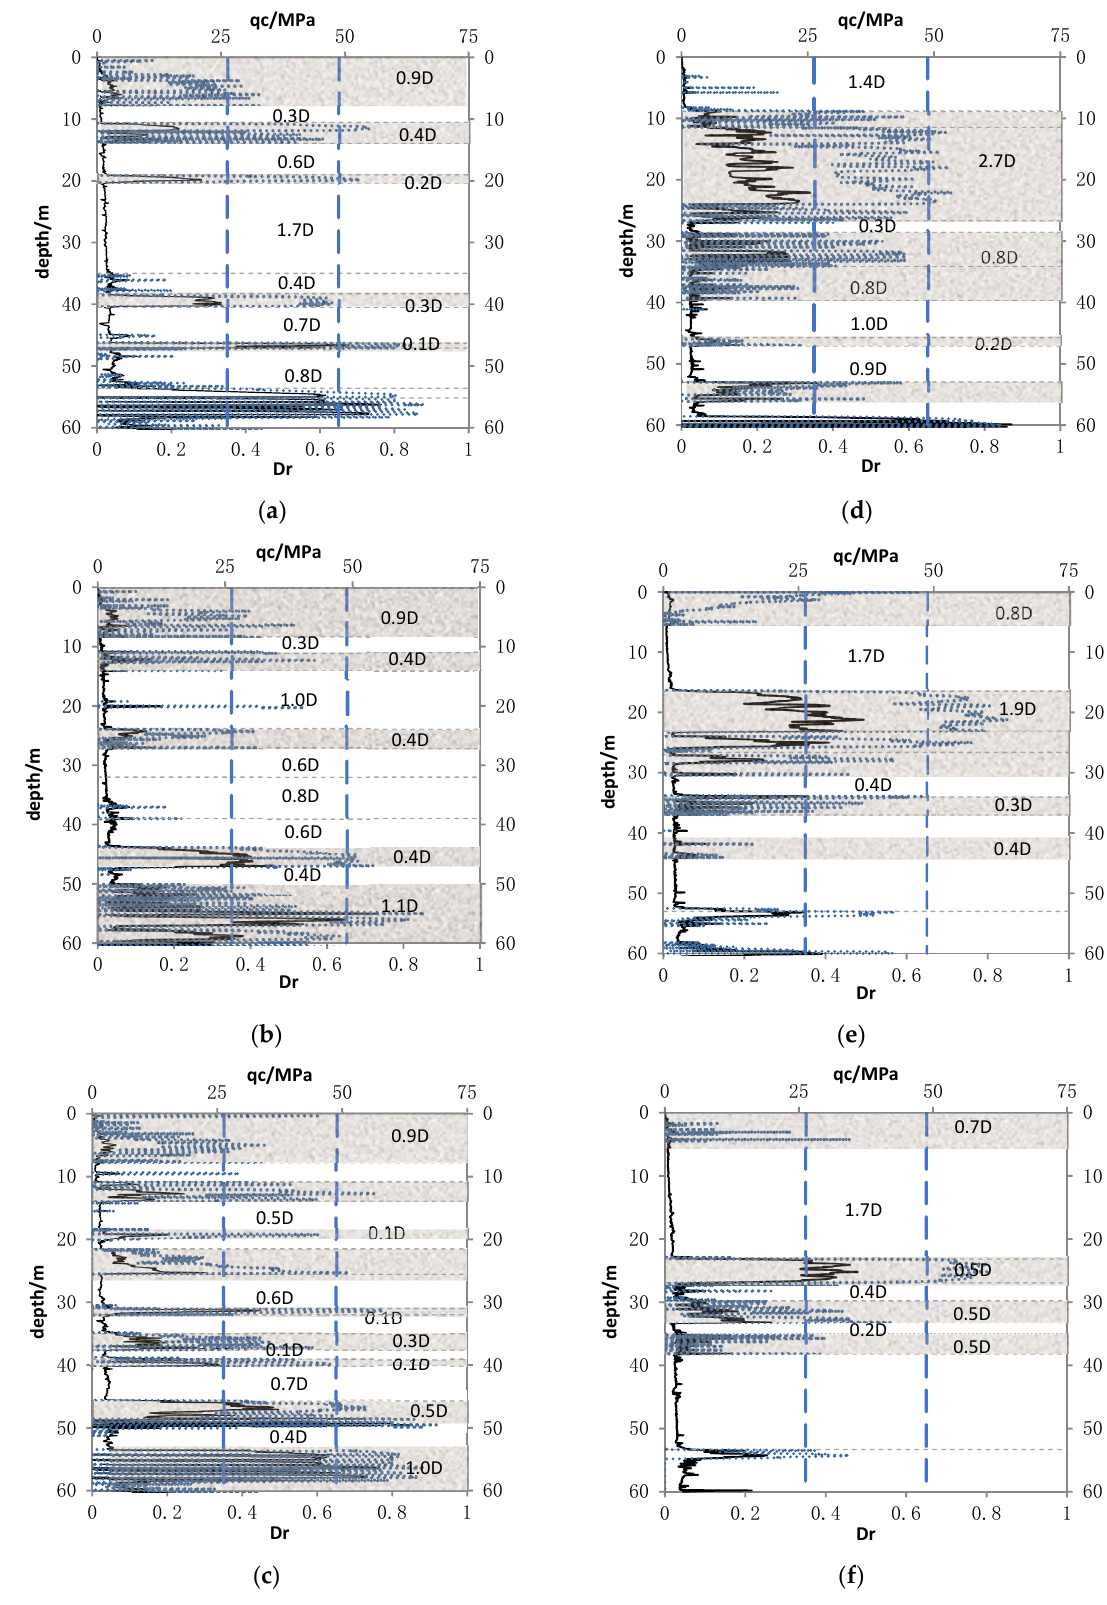
Figure 2. qc of CPT and D r for sand. ( a ) Case 1 (a); ( b ) Case 1 (b); ( c ) Case 1 (c); ( d ) Case 2 (a); ( e ) Case 2 (b); ( f ) Case 2 (c).